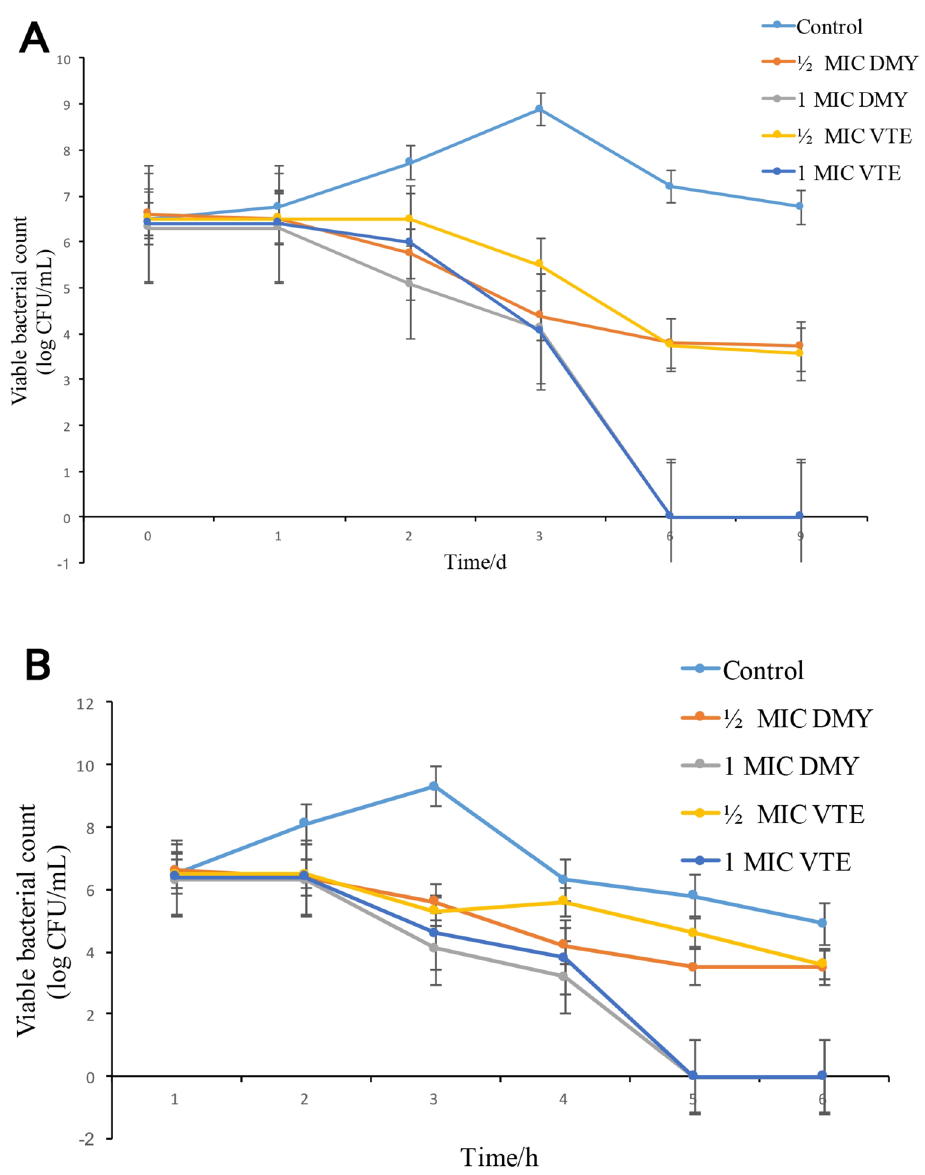
Figure 10. Statistical figure of bacterial colonies in the Challenge of anticorrosion of Chinese Cabbage Juice ( A ). Statistical figure of bacterial colonies in the Challenge of anticorrosion of wort Food ( B